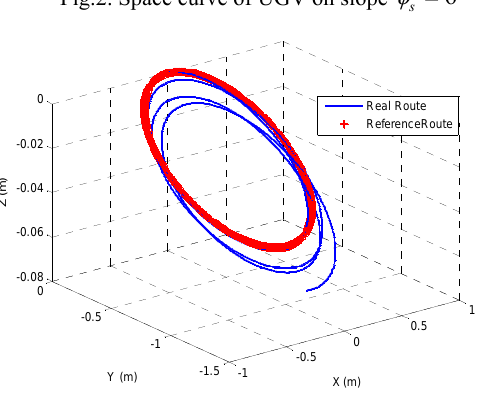
Fig.2. Space curve of UGV on slope